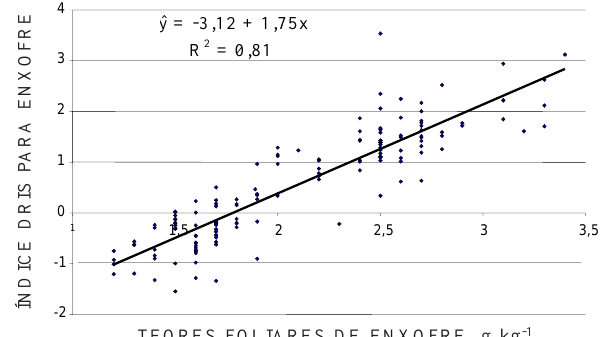
Figura 1. Índices DRIS para enxofre, considerando seus teores foliares de cafeeiros ( C. arabica L.) do sul de Minas Gerais.